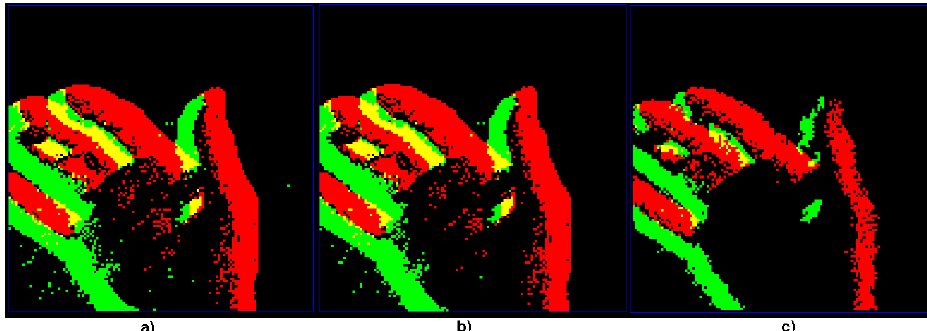
Figure 5. Comparison among the original DVS camera data, jAER “background activity filter” and the proposed LDSI algorithm: ( a ) original events from event-based camera with no filter, where noise and repetitive data were generated, mainly at the object borders; ( b ) result after applying the background noise jAER built-in filter with restrictive parameters; and ( c ) events produced after applying the LDSI algorithm with parameters selected for a compromise between data reduction and loss of main data of the scene (medium